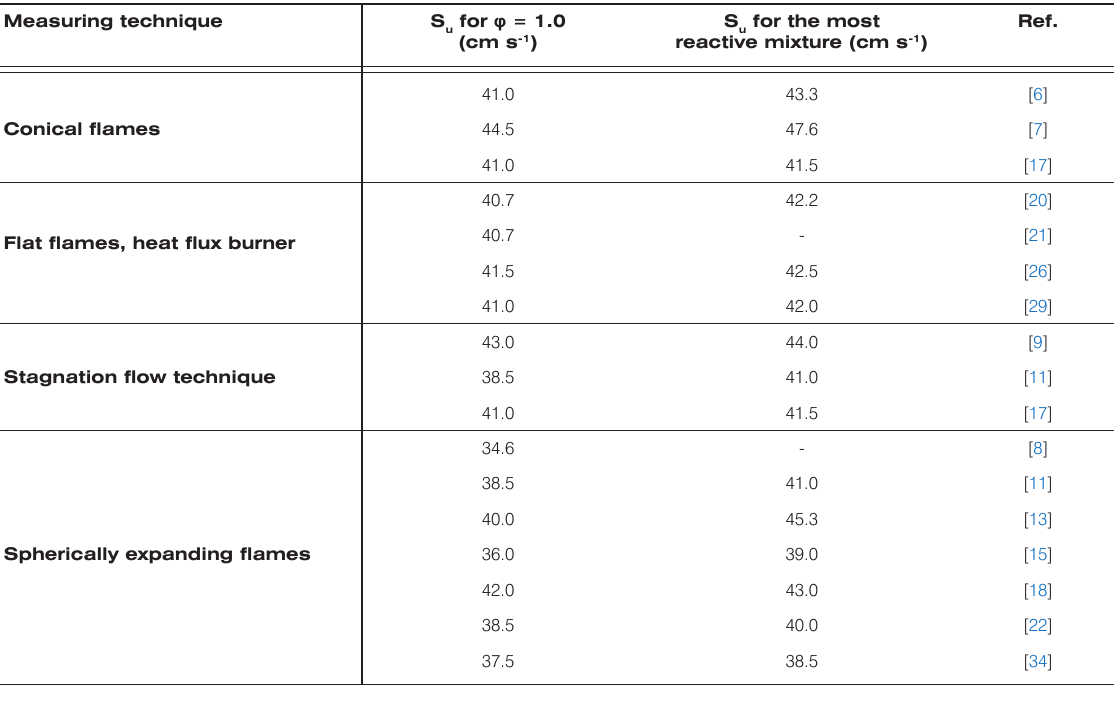
Stagnation flow technique